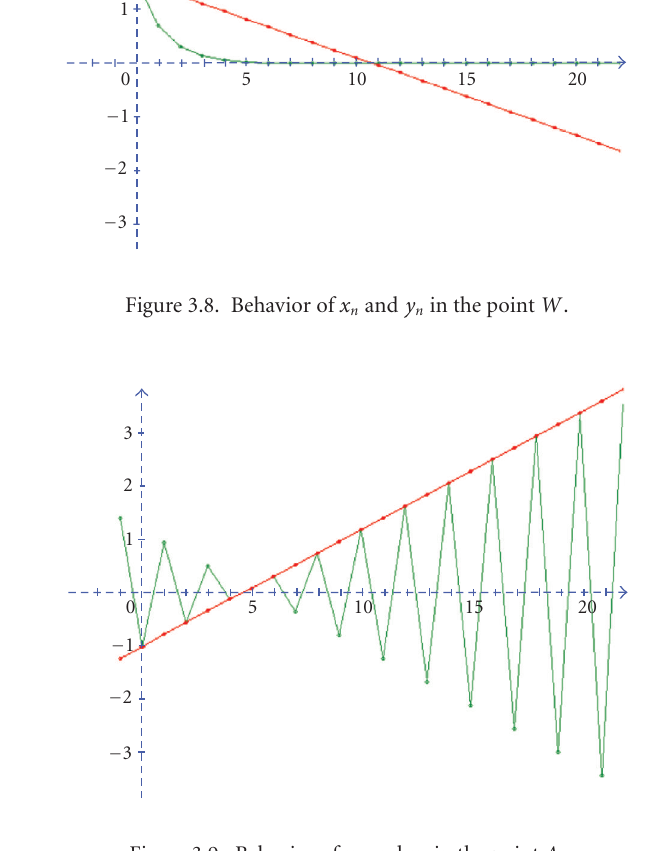
Figure 3.9. Behavior of x n and y n in the point A